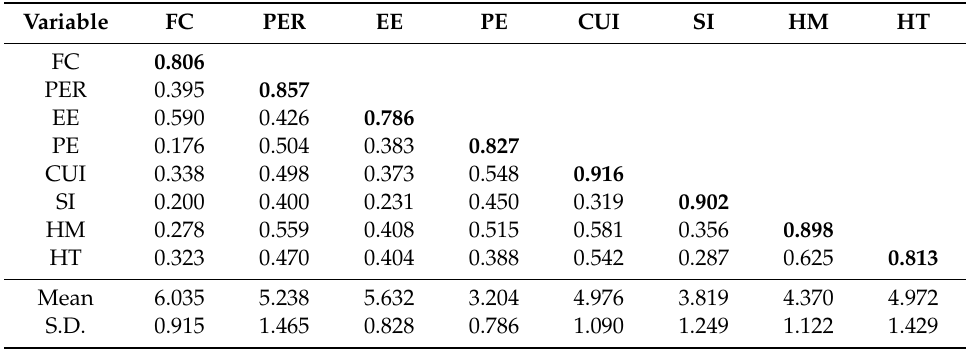
Table 3. Discriminant validity test.